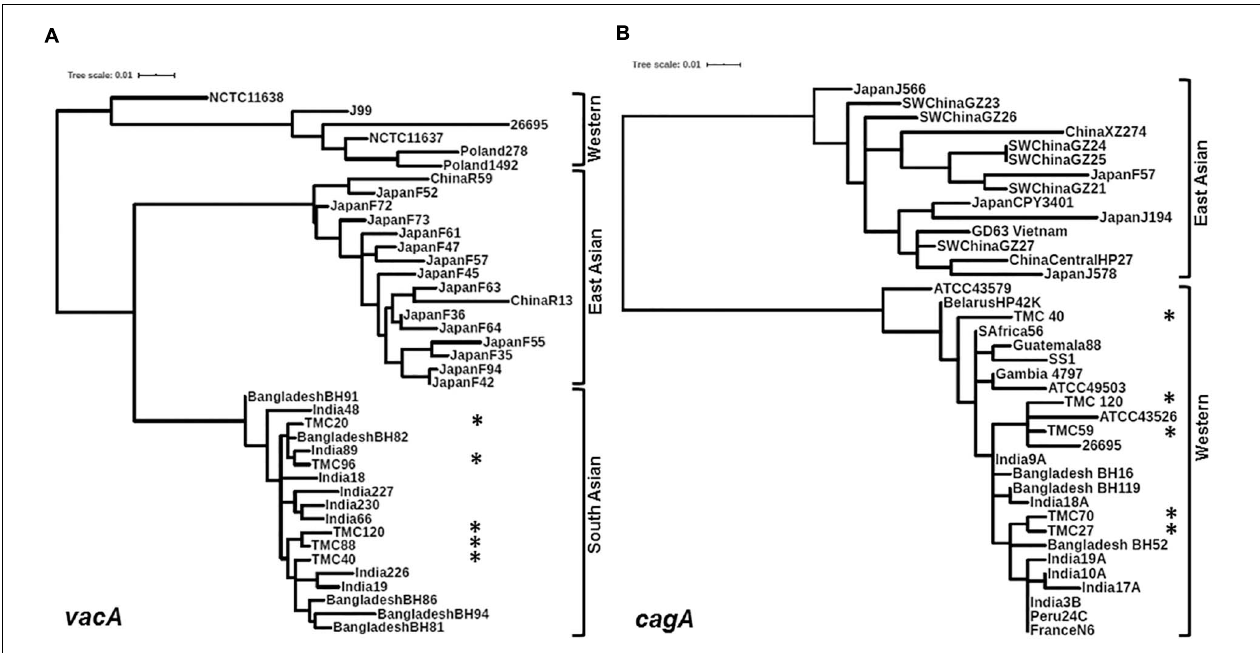
FIGURE 3 | (A) Phylogenetic analysis of the vacAm1 . The vacAm1 of Trivandrum H. pylori strains (named as TMC and shown as asterisks) are closely related to the vacAm1 of the H. pylori strains from South Asia, but differ from the vacAm1 of H. pylori strains from Western world and East Asia. The H. pylori vacAm1 sequences and their GenBank accession numbers are: TMC20 (MN968508); TMC40 (MN968509); TMC88 (MN968510); TMC96 (MN968511); TMC120 (MN968512); NCTC 11638 (HPU07145); Poland 1492 (AF097570); Poland 278 (AF097571); NCTC 11637 (AF049653); J99 (AE001511); 26695 (AE000598); Japan F73